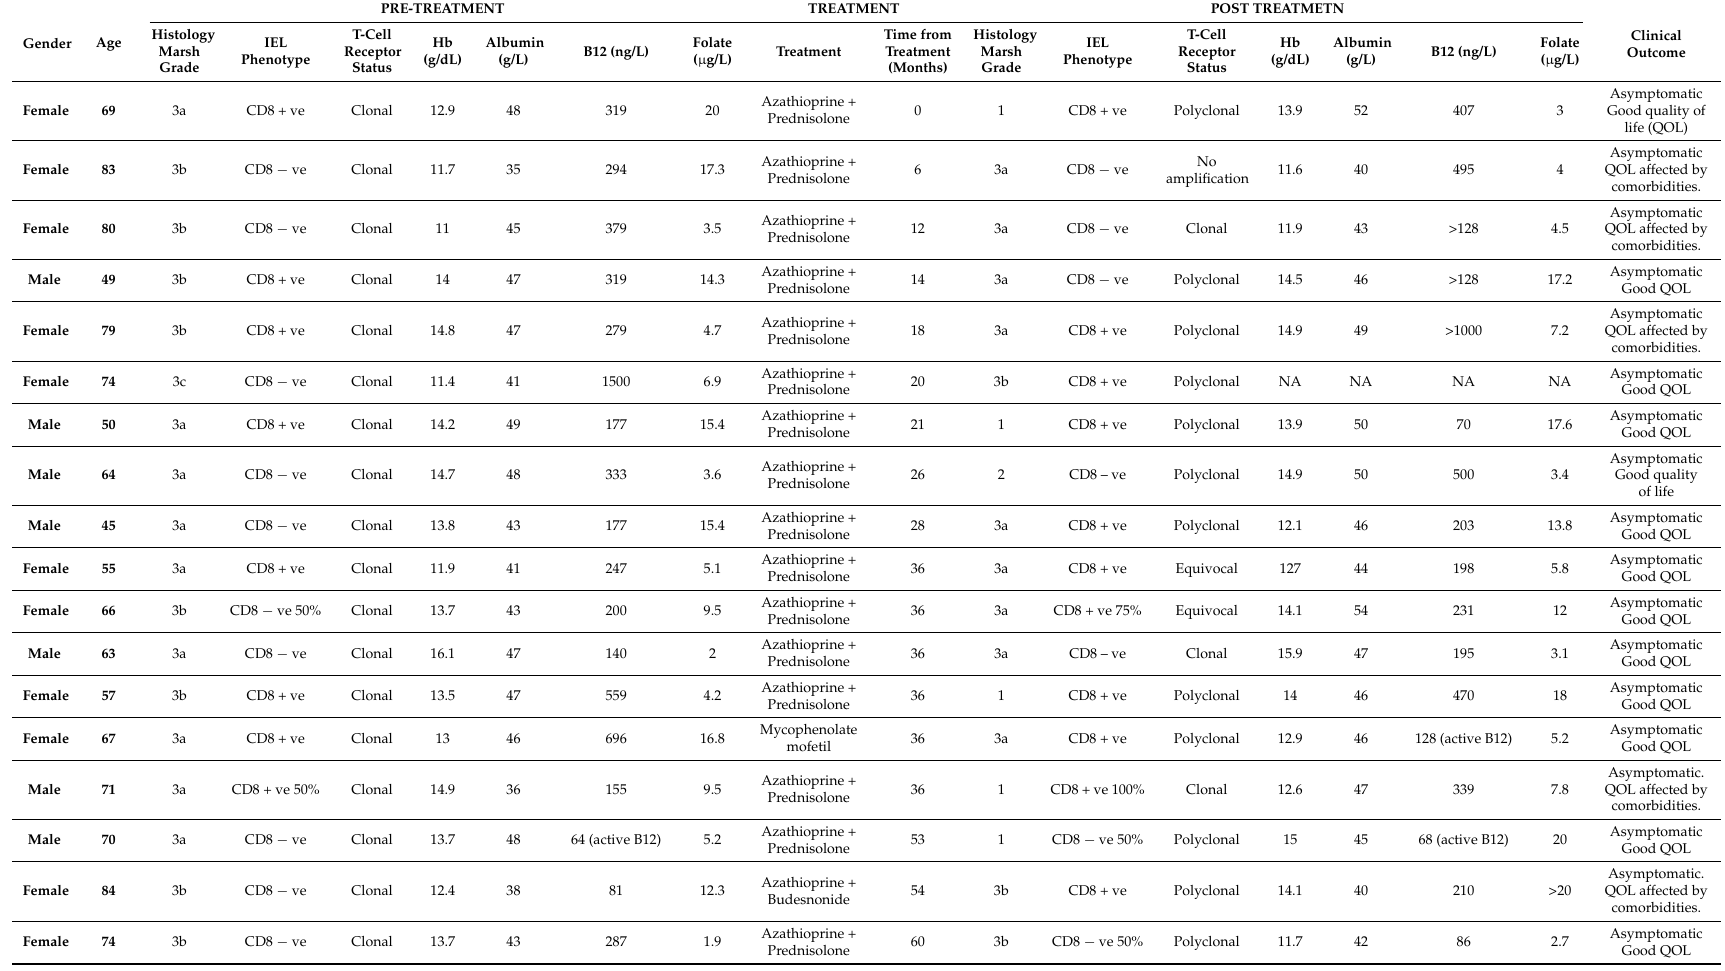
Table 2. Baseline and post-treatment follow up data for patients with refractory coeliac disease type 2 who completed